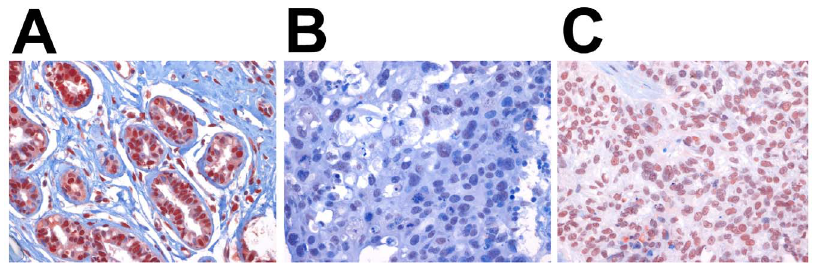
Figure 1. Immunohistochemical staining of APE1. A . Nuclear staining in the luminal epithelium of normal breast ducts and lobules. B . Low, and C . high nuclear APE1 expression in invasive breast cancer. (magnification 6